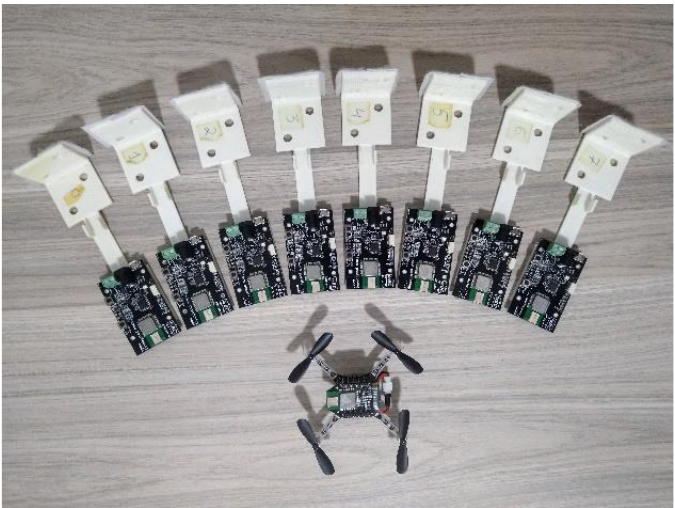
Figure 4. Anchors and quadcopter Crazyflie 2.0.